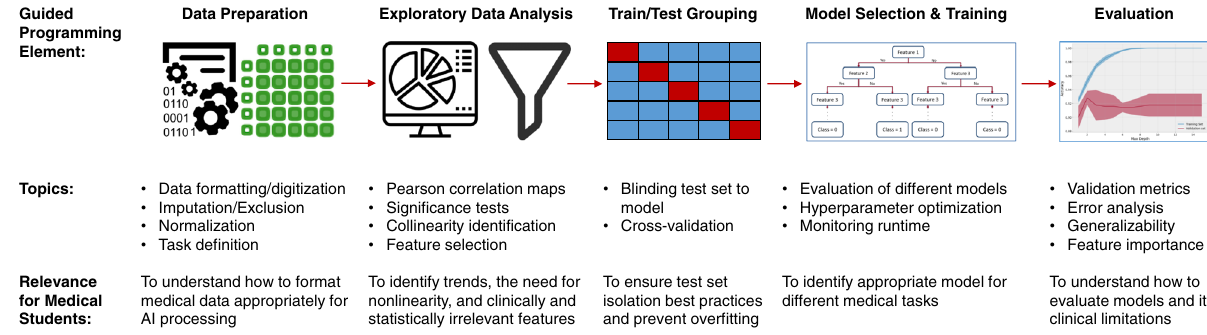
Fig. 2 A pipeline of the programming examples developed with speci fi c concepts to be implemented. Programs are introduced during the week of the relevant topic and examples chosen were from published arti fi cial intelligence applications. Programming elements were only included if deemed relevant to provide insight in future clinical practice, such as how to evaluate models to understand if they are ready to be applied in a clinical trial. The examples culminate in a full end-to-end application to classify tumors as benign or malignant based on medical image